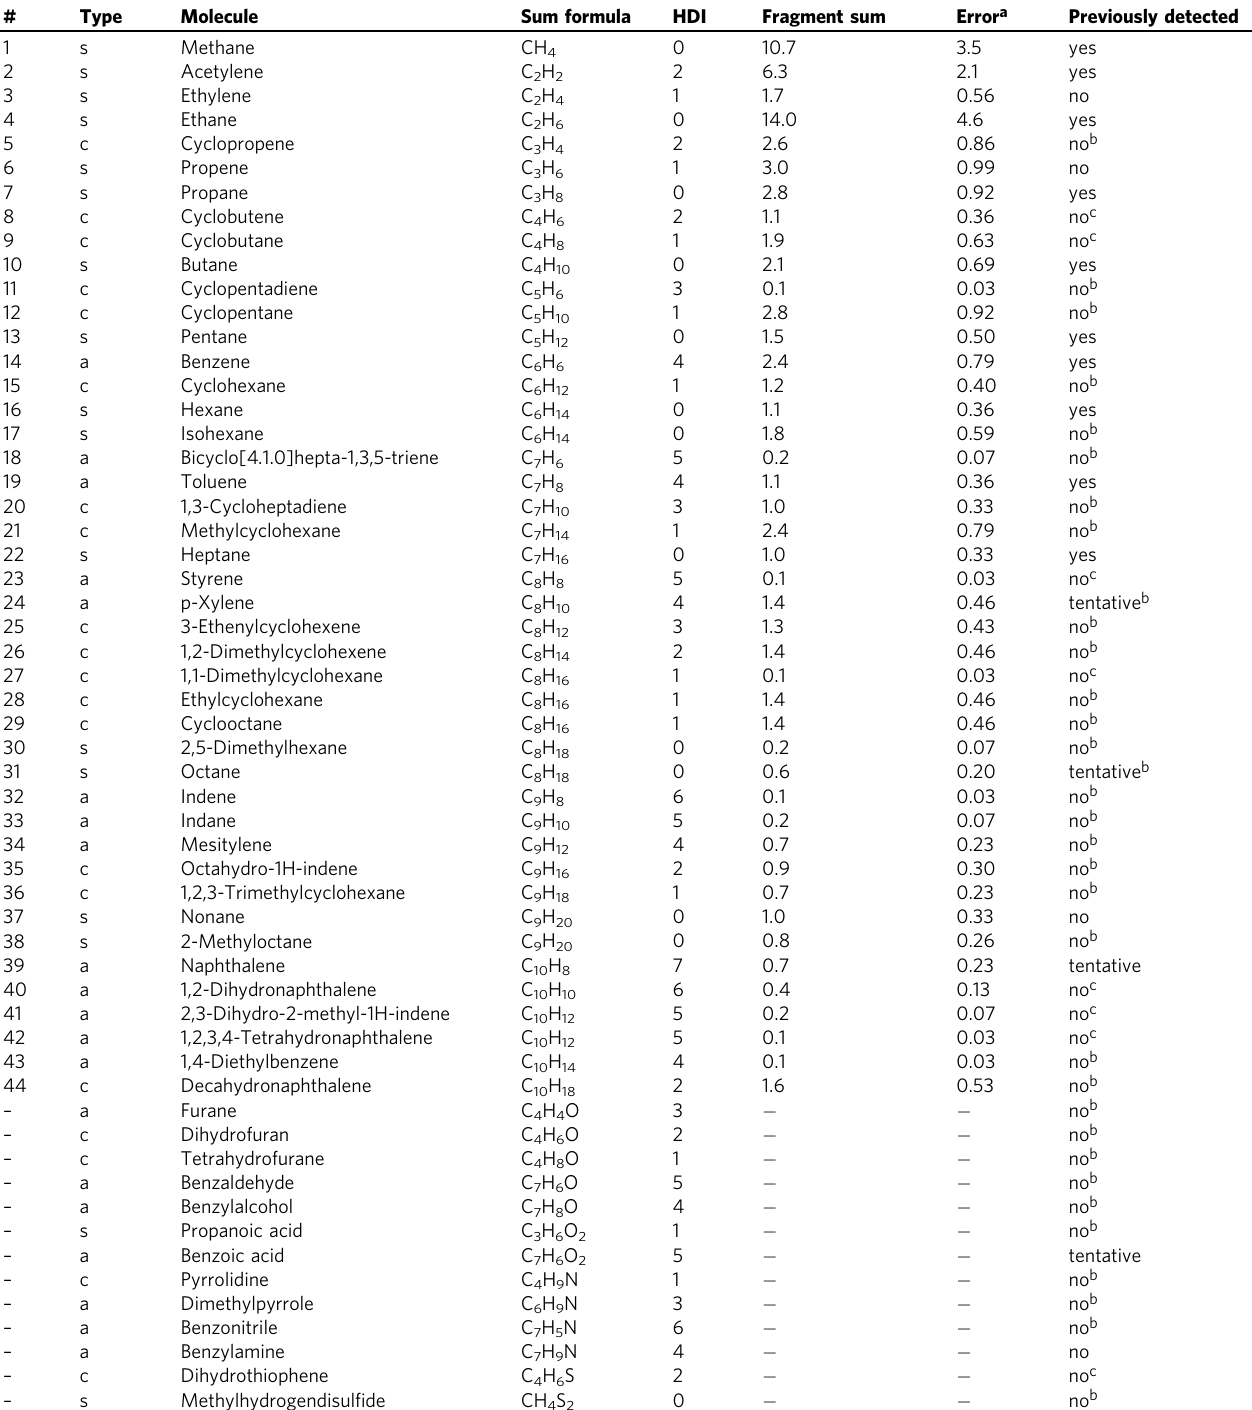
Table 1 List of molecules identi fi ed in the coma of 67P on 3 August